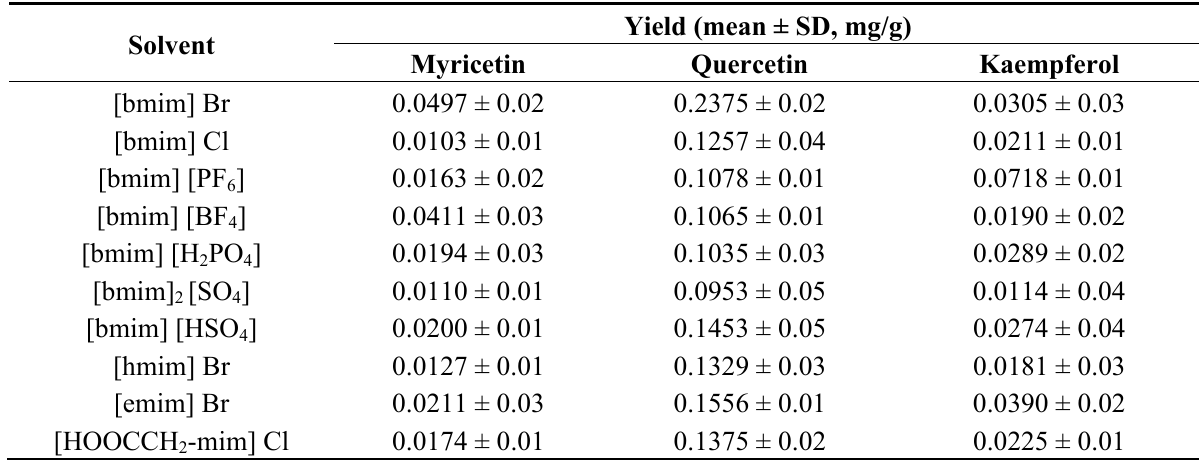
Table 1. ILs’ effects on yields of myricetin, quercetina and kaempferol.